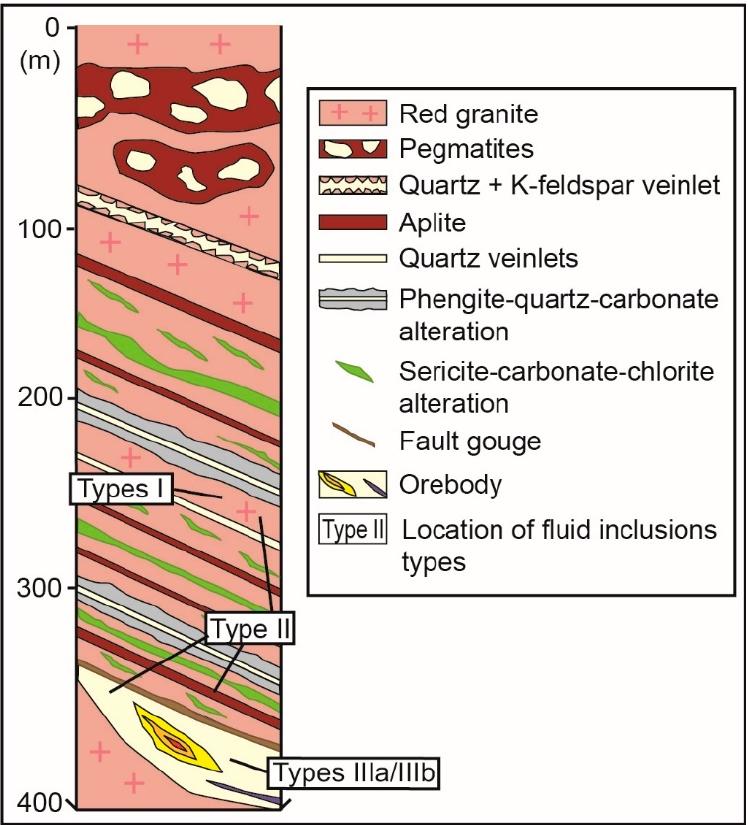
Figure 6. Schematic and synthetic sketch of drill hole vertical section showing the distribution of the main alteration zones and mineralised veins in the Barreiro zone.